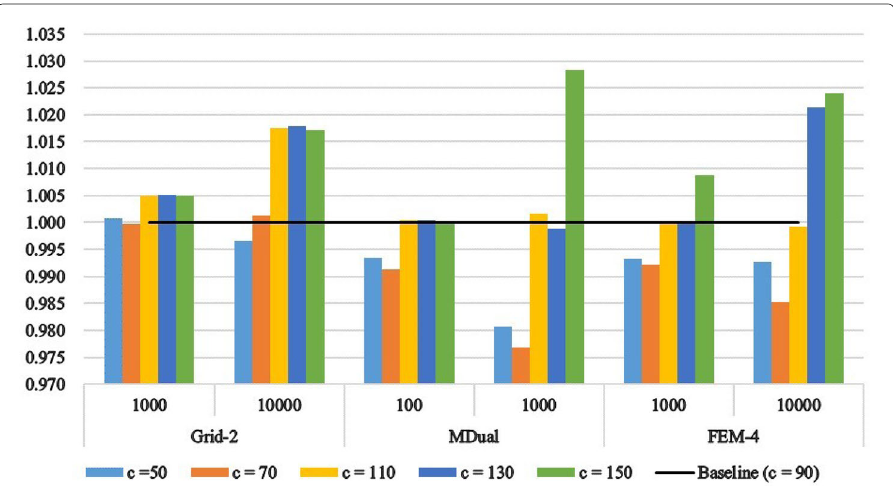
Fig. 6 The ratios of max-load of other contracted parameters to that of parameter